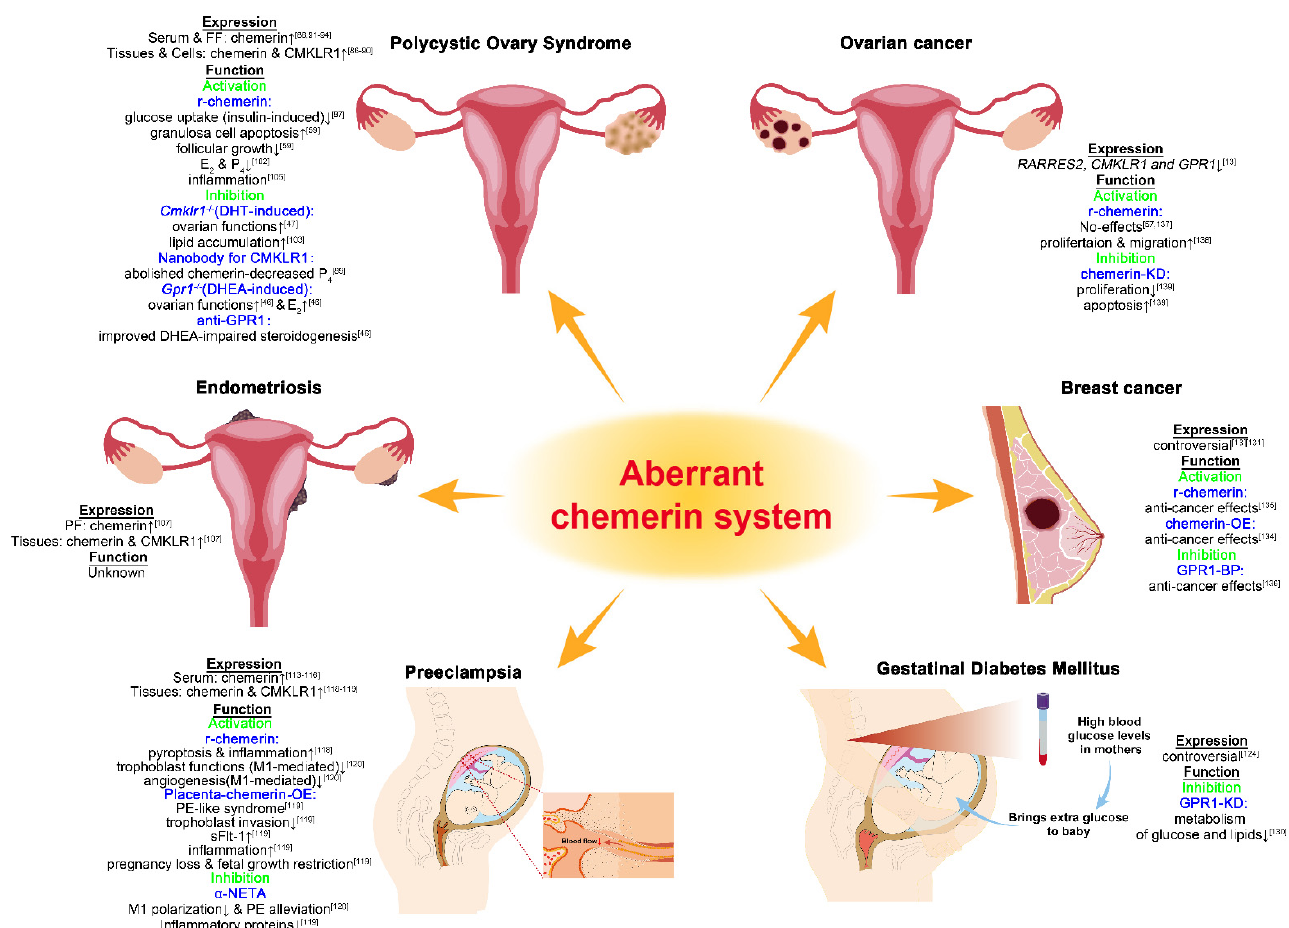
Figure 3. The roles of the chemerin system in reproductive system diseases. The emerging knowledge about the roles of the chemerin system in reproductive system diseases, including PCOS, endometriosis, preeclampsia, GDM, breast cancer, and ovary cancer. Up-regulated levels of chemerin were found in PCOS (serum, FF, and tissues), endometriosis (PF and tissues), and preeclampsia (serum and tissues), indicating a potential diagnostic value for clinical application. The expression status of the chemerin system in GDM, breast cancer, and ovarian cancer requires further verification. Inhibition of CMKLR1 showed potential therapeutic effects for PCOS ( Cmklr1 -/- and nanobodies) and preeclampsia ( α -NETA). Inhibition of GPR1 showed potential therapeutic effects for PCOS ( Gpr1 -/- and antibodies), GDM (shRNA), and breast cancer (GPR1-BP). r-chemerin or chemerin-OE displayed a potential anti-breast cancer effect. FF, follicular fluids; PF, peritoneal fluids; r-chemerin, recombinant chemerin. KD, knockdown; OE, overexpression; GPR1-BP, GPR1-binding peptide.